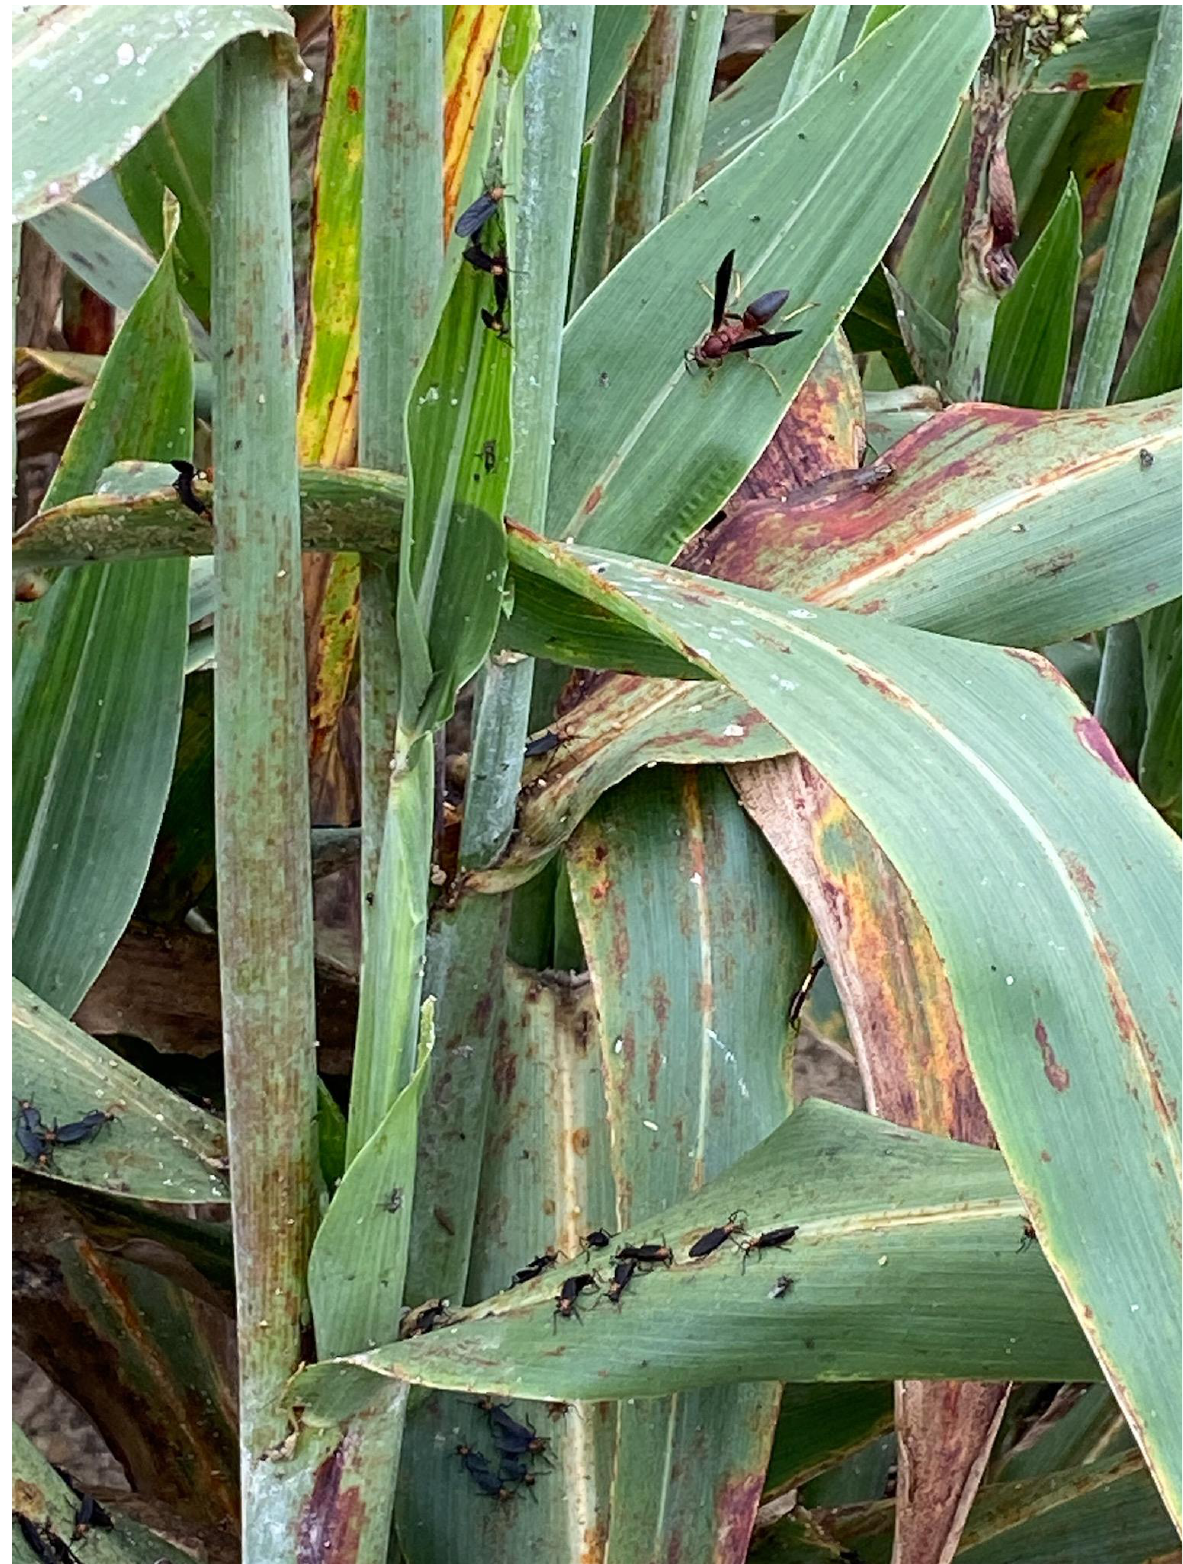
Figure 1. Hymenoptera attracted to honeydew on grain sorghum infested with sorghum aphid, Melanaphis sorghi